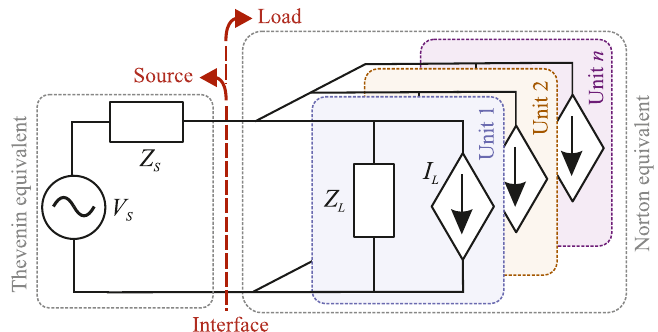
Figure 3. Source-load equivalent circuit for parallel-connected